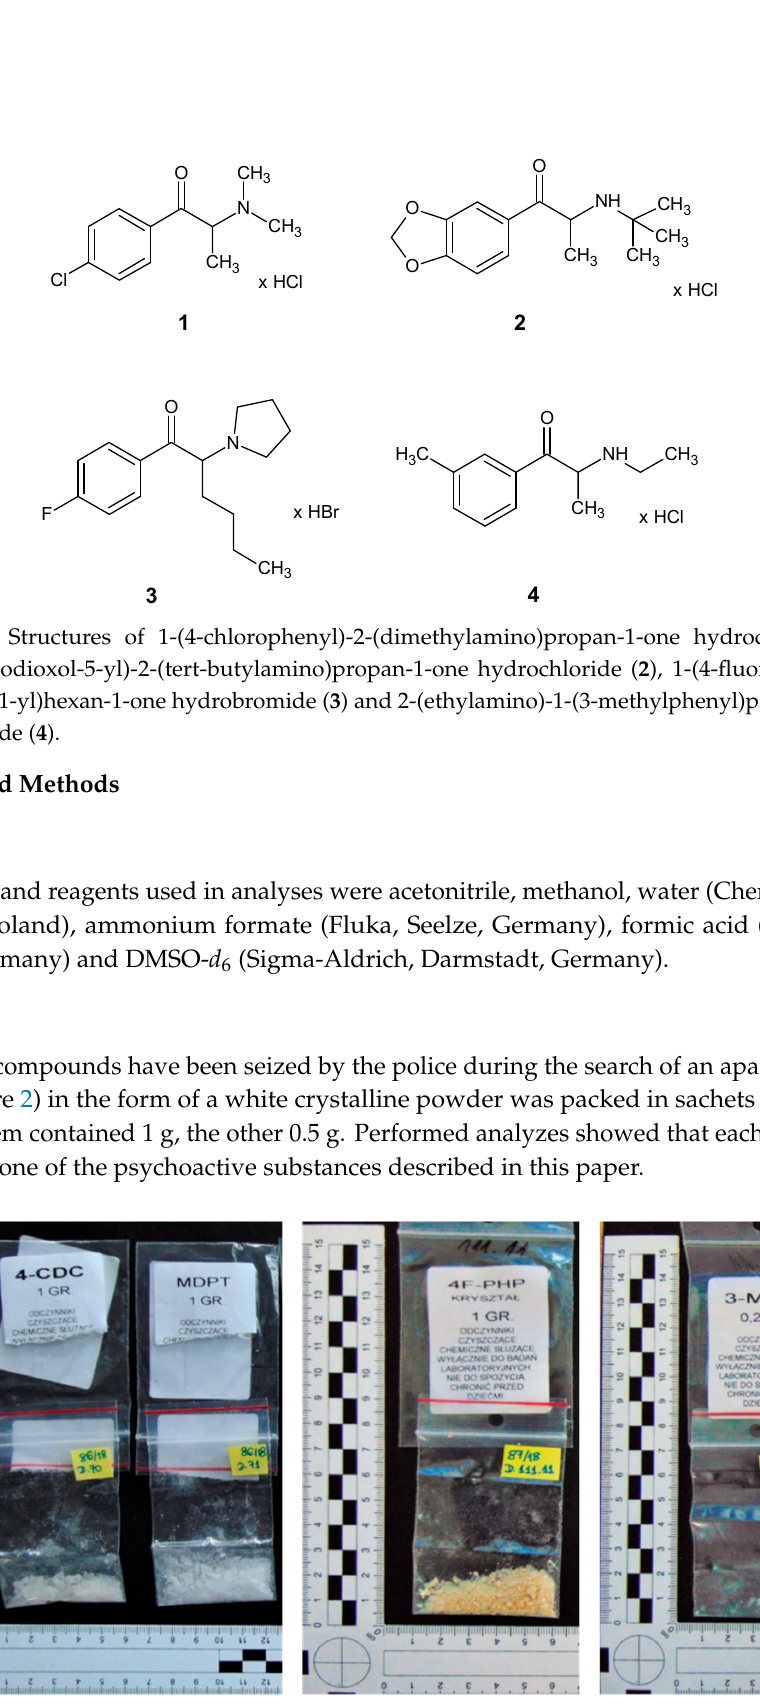
Figure 2. Material evidence seized by the police. From left to right : 1-(4-chlorophenyl)-2- (dimethylamino)propan-1-one hydrochloride ( 1 ), 1-(1,3-benzodioxol-5-yl)-2-(tert-butylamino) propan-1-one hydrochloride ( 2 ), 1-(4-fluorophenyl)-2-(pyrrolidin-1-yl)hexan-1-one hydrobromide ( 3 ) and 2-(ethylamino)-1-(3-methylphenyl)propan-1-one hydrochloride ( 4